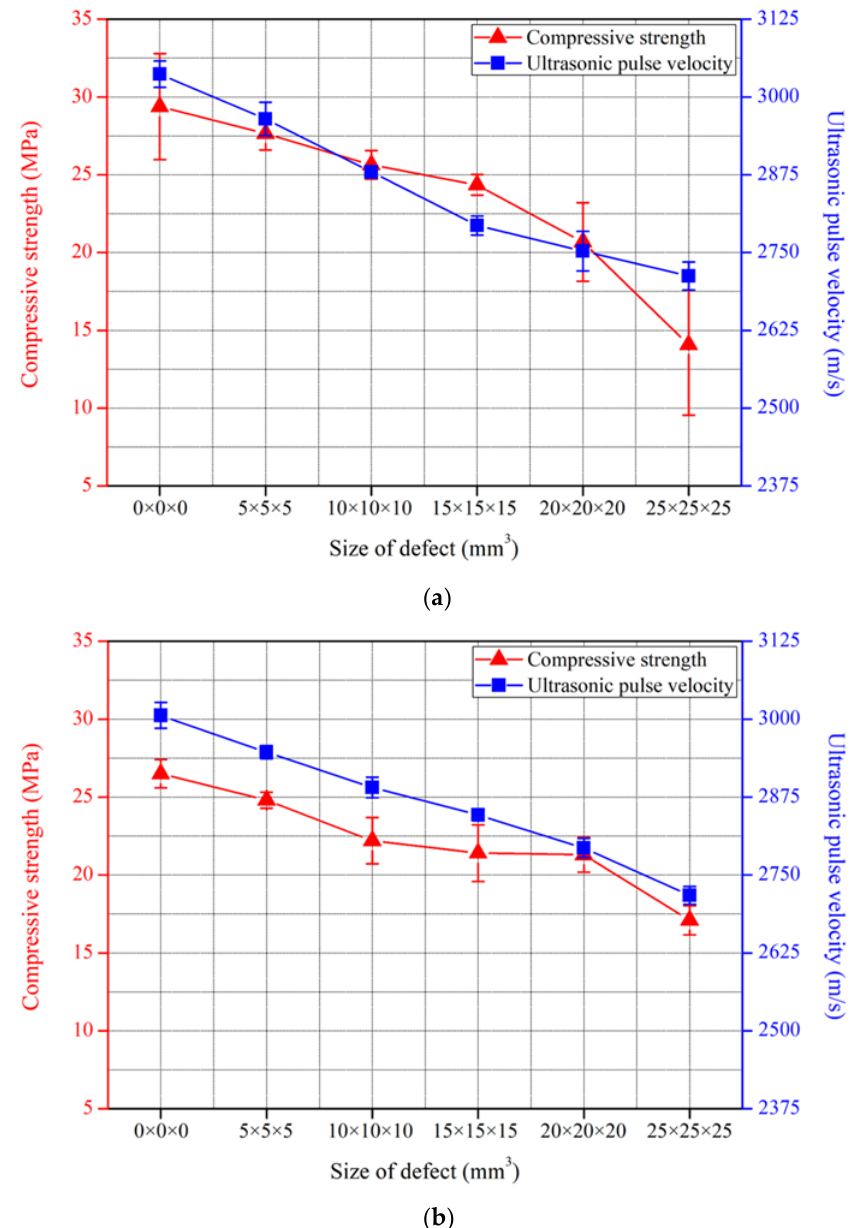
Figure 10. Comparison between compressive strength and ultrasonic pulse velocity: ( a ) MWCNT 0.0 wt%; ( b ) MWCNT 1.0 wt%.